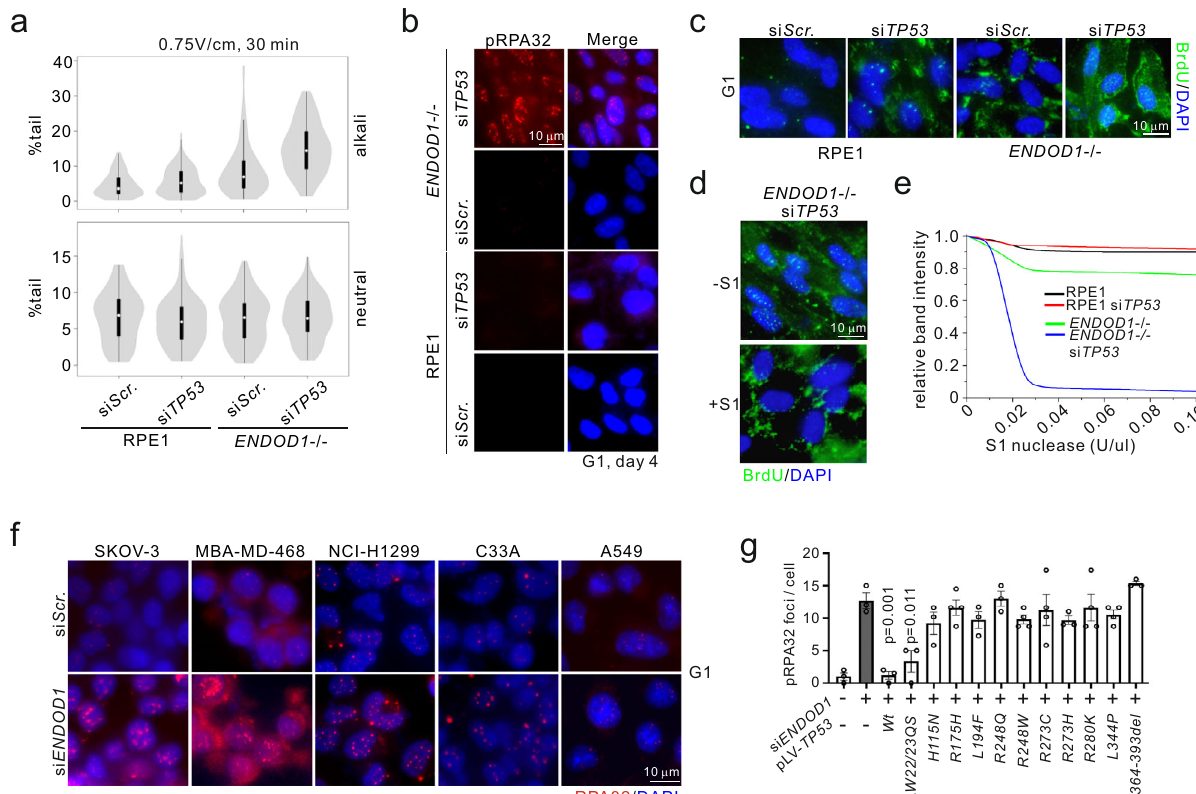
Fig. 4 SL between ENDOD1 and TP53 correlates with ssDNA formation. a Quanti fi cation of tail moments for neutral (bottom) and alkali (top) comet assays in G1-arrested ENDOD1 − / − and control RPE1 cells treated with si TP53 or control siRNA. n = 150 cells from each of 3 biologically independent experiments. White dot: median. Thick whisker: third quartile. Thin whisker: upper/lower adjacent values (1.5x inter-quartile range). b Immuno fl uorescent staining for pRPA32 in ENDOD1 − / − and control RPE1 G1 arrested cells 96 h following si TP53 or control treatment. Merged image is with DAPI staining. c Equivalent experiment as in ( b ), non-denatured staining for BrdU that was incorporated into cells before serum starvation. d Non-denatured BrdU signals in ENDOD1 − / − si TP53 cells with or without prior S1 nuclease digestion. Representative of 3 independent experiments. e Quanti fi cation of agarose gel band intensity of undigested genomic DNA puri fi ed from the indicated cells after treatment with the speci fi ed units of S1 nuclease. Representative image of 3 independent experiments. A representative original gel for 0.02 U/ μ l is shown in Supplementary Fig. 5e. f pRPA32 staining in cancer cell lines that harbour TP53 mutations 72 h after treatment with control (si Scr .) or si ENDOD1 . A549 is a TP53 wild type control. g . Quanti fi cation of pRPA32 foci in si ENDOD1 treated SKOV-3 cells complemented with the indicated TP53 alleles. n = 3 – 4 biologically independent experiments. Error bars; SEM. Signi fi cance test: two- tailed Student ’ s t